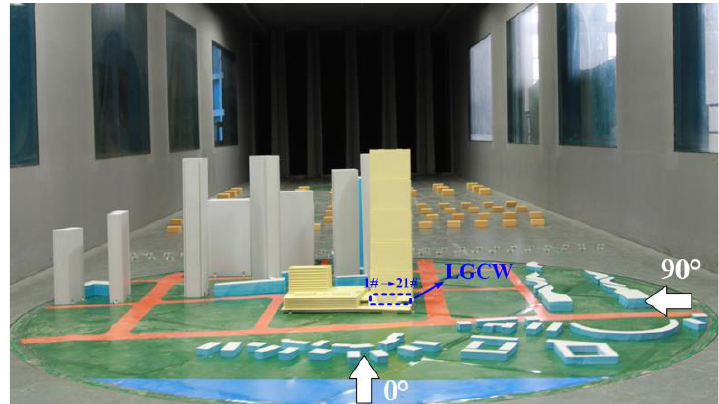
Figure 5. Pressure measurements of the LGCW. Table 2. µ sl of the sl